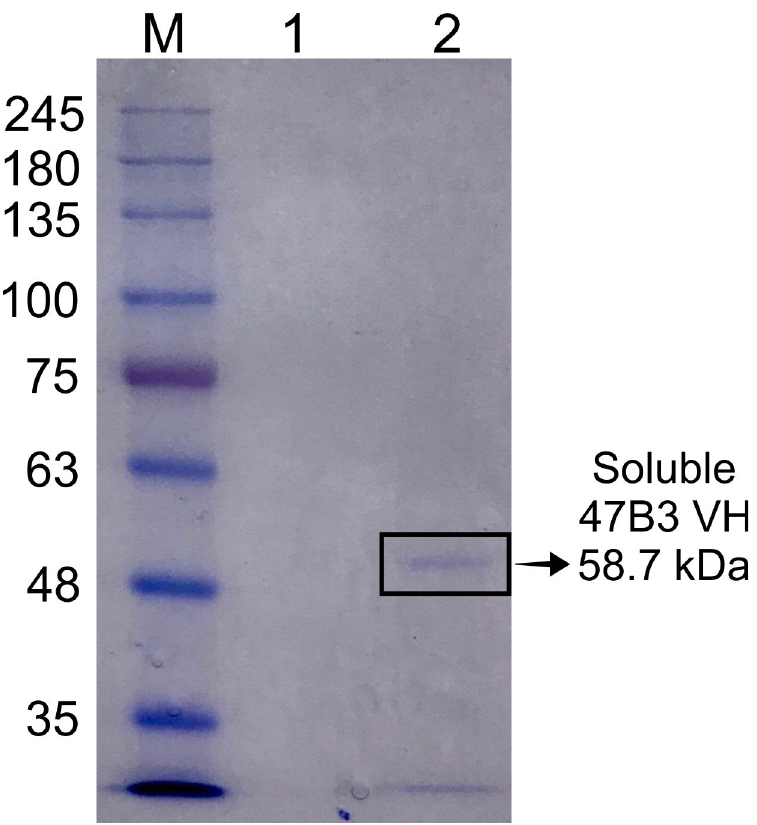
Fig 8. Representative gel showing the soluble 47B3 VH expression, as revealed by SDS-PAGE with Coomassie blue staining. M: Marker; 1: negative control ( E . coli TG1 without phagemid vector); 2: soluble 47B3 VH. VH antibody production was separated on a reducing 8% SDS-PAGE.